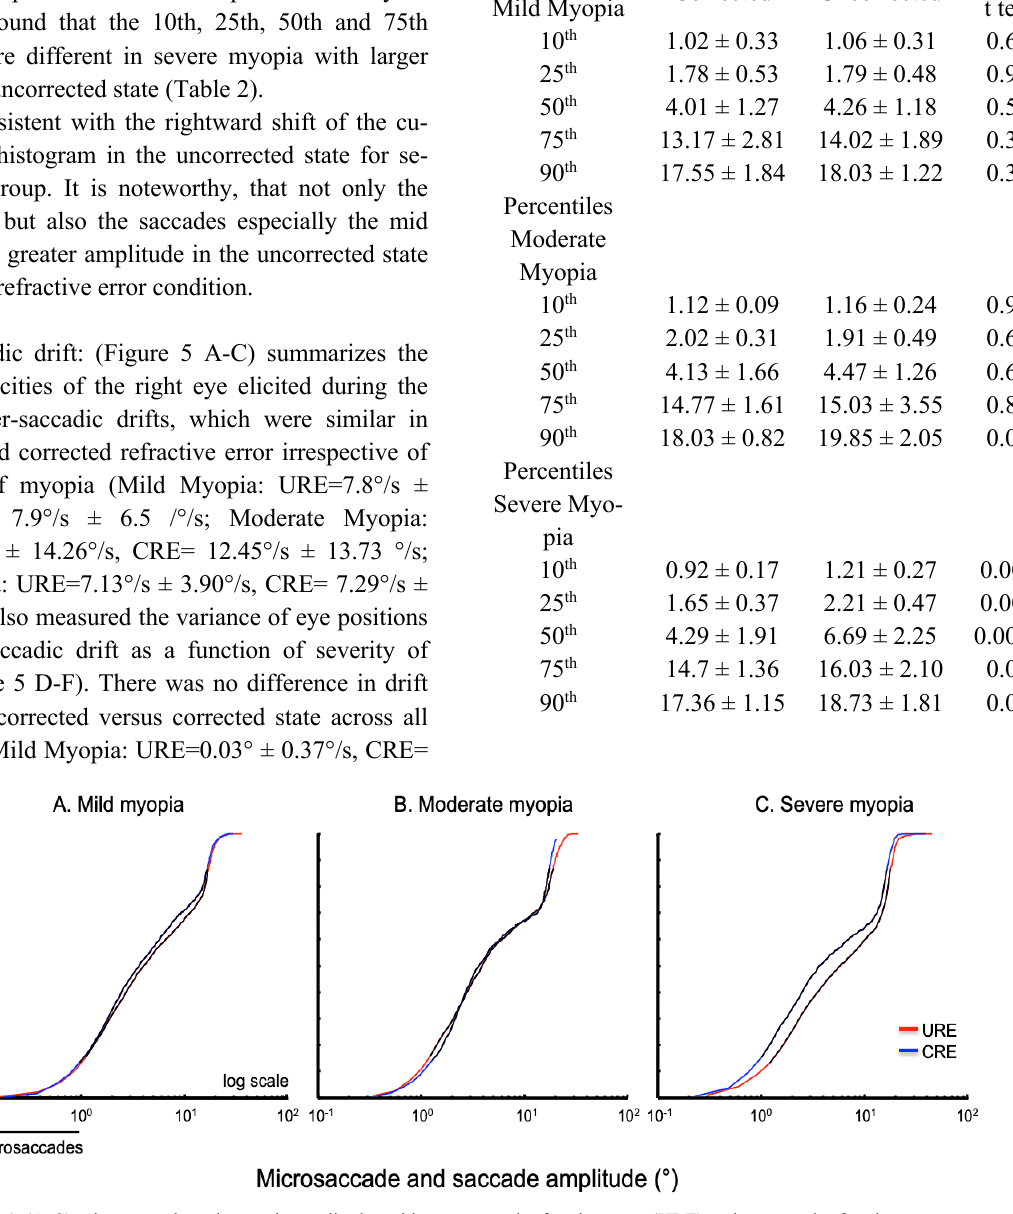
Figure 4. (A-C) microsaccade and saccade amplitudes with uncorrected refractive error (URE) and corrected refractive error (CRE). Microsaccades are those less than 1° in amplitude (arrow). (C) Amplitudes of microsaccades and saccades are larger in subjects with high myopia as indicated by the rightward